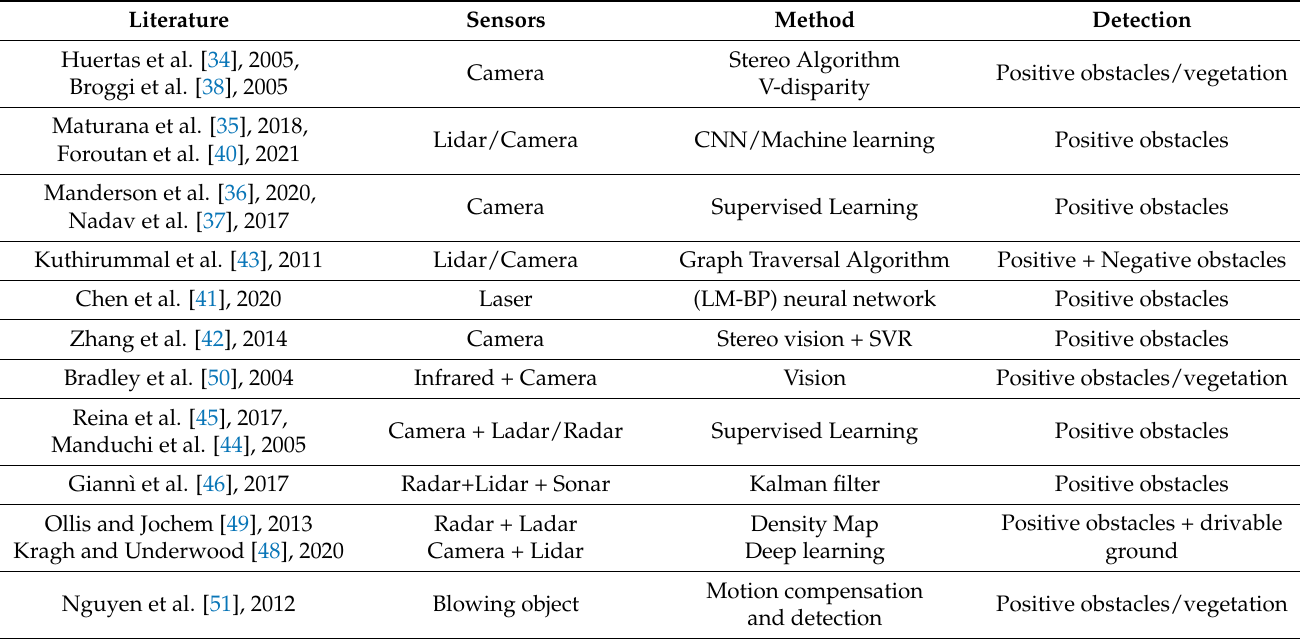
Table 3. The methods used for positive obstacle